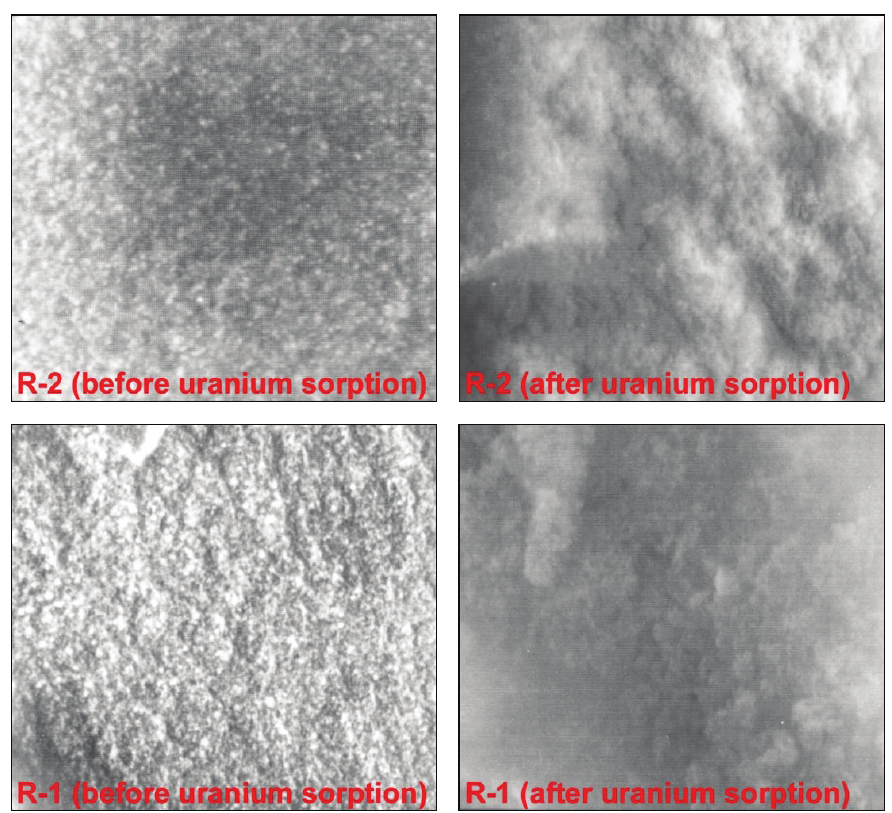
Figure 2: The scanning electron microscopy images of the studied resins before and after uranium sorption.